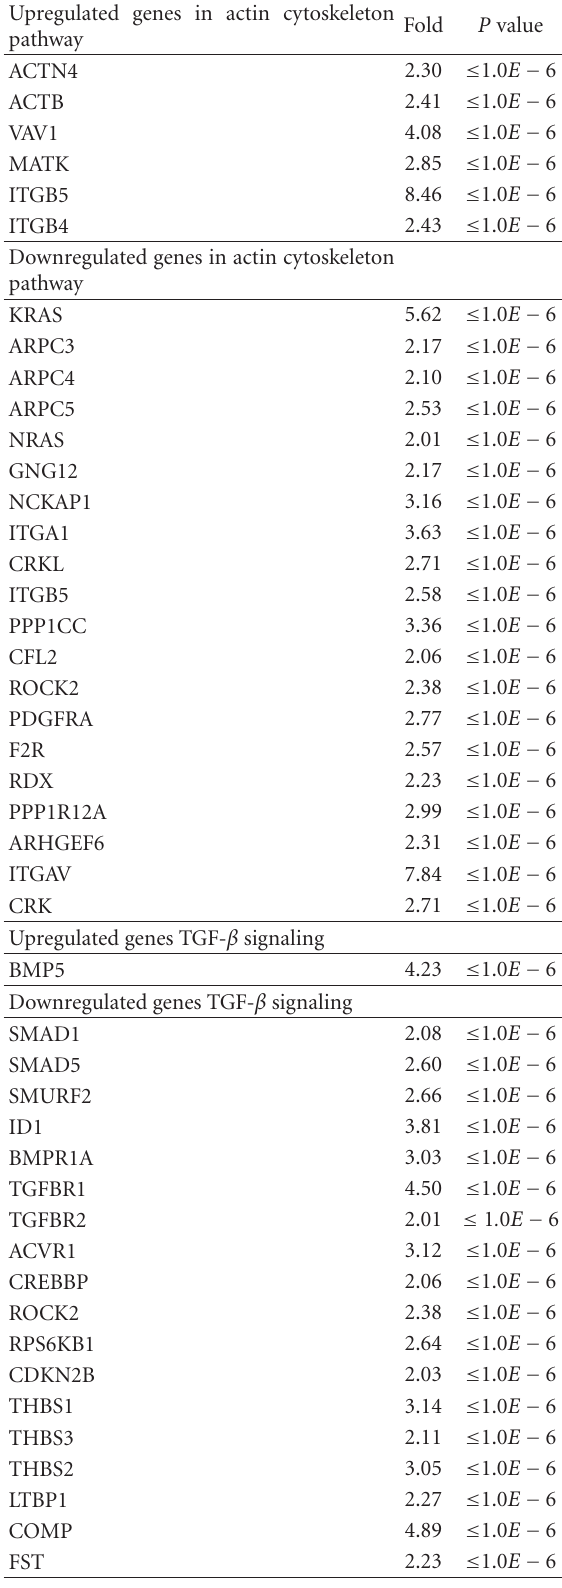
Table 2: Di ff erentially expressed genes in regulation of actin cy- toskeleton and TGF- β signaling between SLE patients and normal